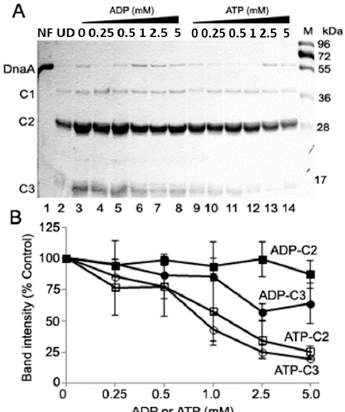
Figure 3. ADP-DnaA and ATP-DnaA confers different resistance to chymotrypsin protease. ( A ) Nucleotide free, ADP and ATP-DnaA protein (1.5 μ M) were subjected to proteolysis by chymotrypsin (protein: protease molar ratio of 4.0) for 30 min at 30 °C. Lane 1, Undigested (UD) nucleotide free DnaA; Lane 2, Nucleotide free DnaA (NF) treated with chymotrypsin; Lane 3, ADP-DnaA treated with chymotrypsin; Lanes 4–8, ADP-DnaA treated with chymotrypsin in the presence of 0.25, 0.5, 1.0, 2.5